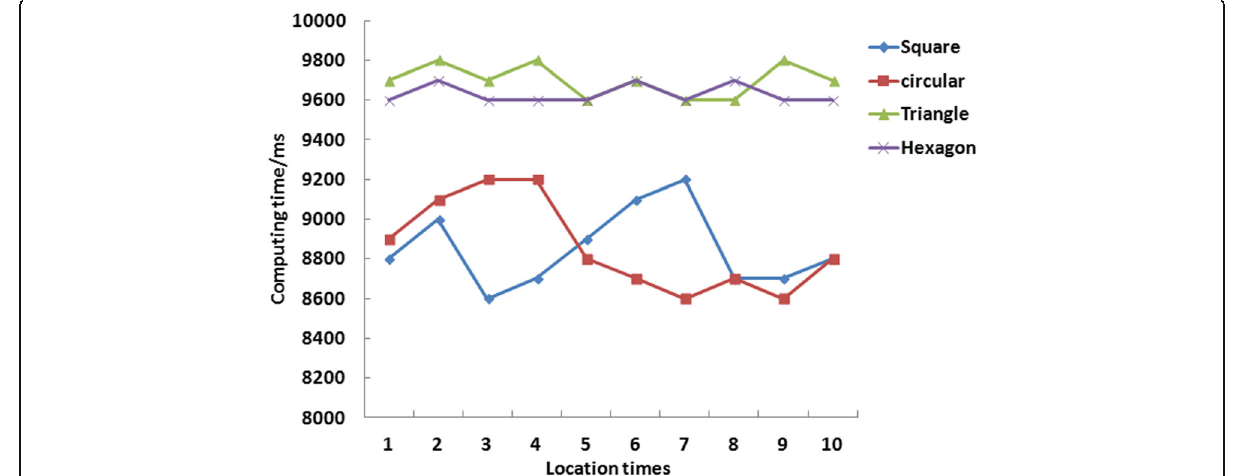
Fig. 8 Comparison of 10 positioning calculation times for different shape models